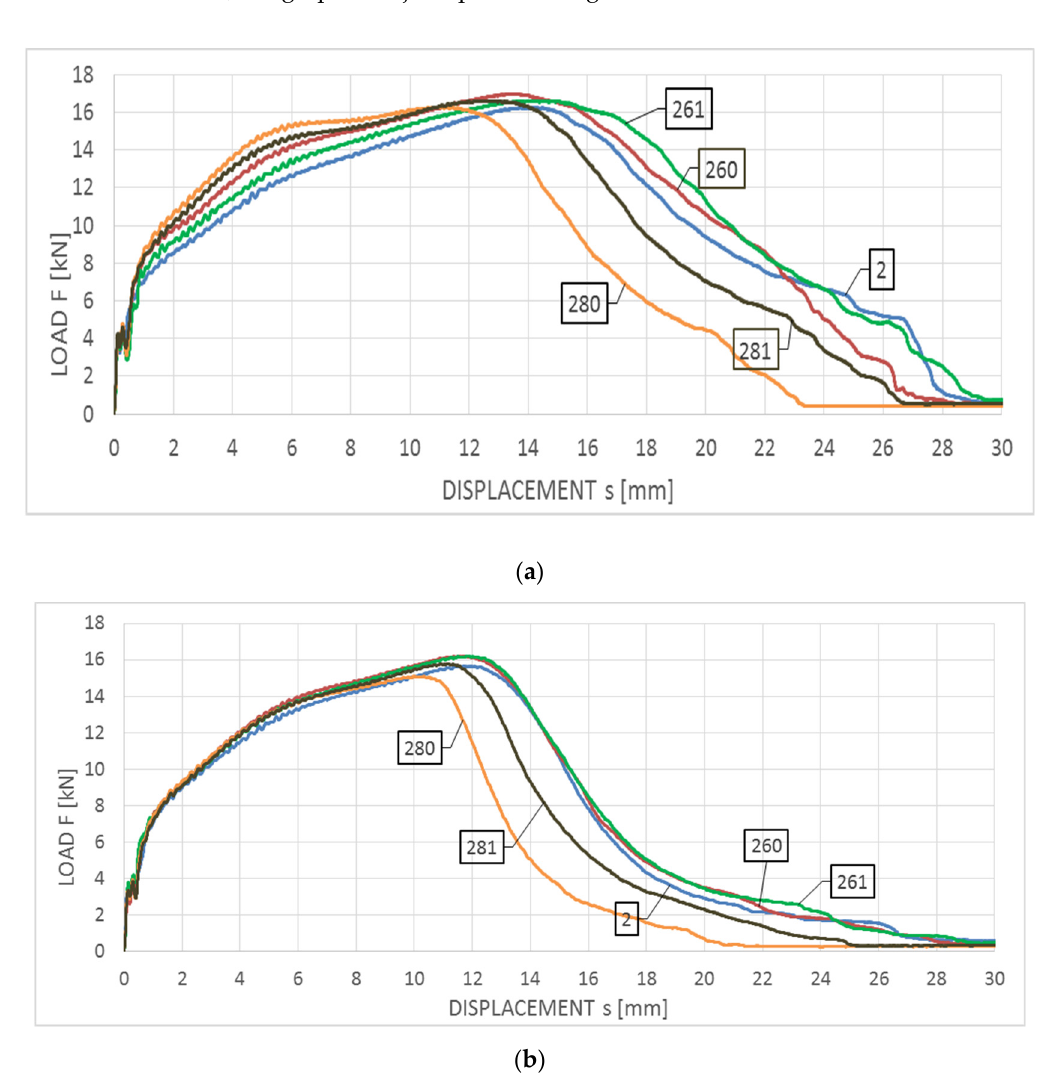
Figure 10. Averaged 𝐹 − 𝑠 curves obtained on samples made of 1H18N9T steel: ( a ) during tests conducted in +20 °C, ( b ) during tests conducted in − 20 °C.